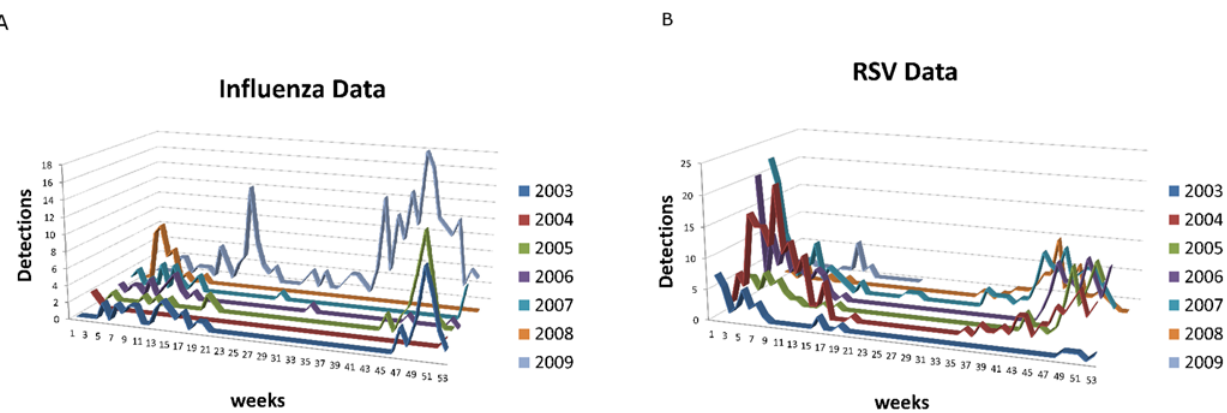
Fig 2. Data 2003 – 2009 from the records maintained by the Virology Laboratory of the Facultad de Medicina, UASLP, San Luis Potosí, Mexico. ( A ) Weekly influenza. ( B ) Weekly RSV. Each individual year is plotted in a separate